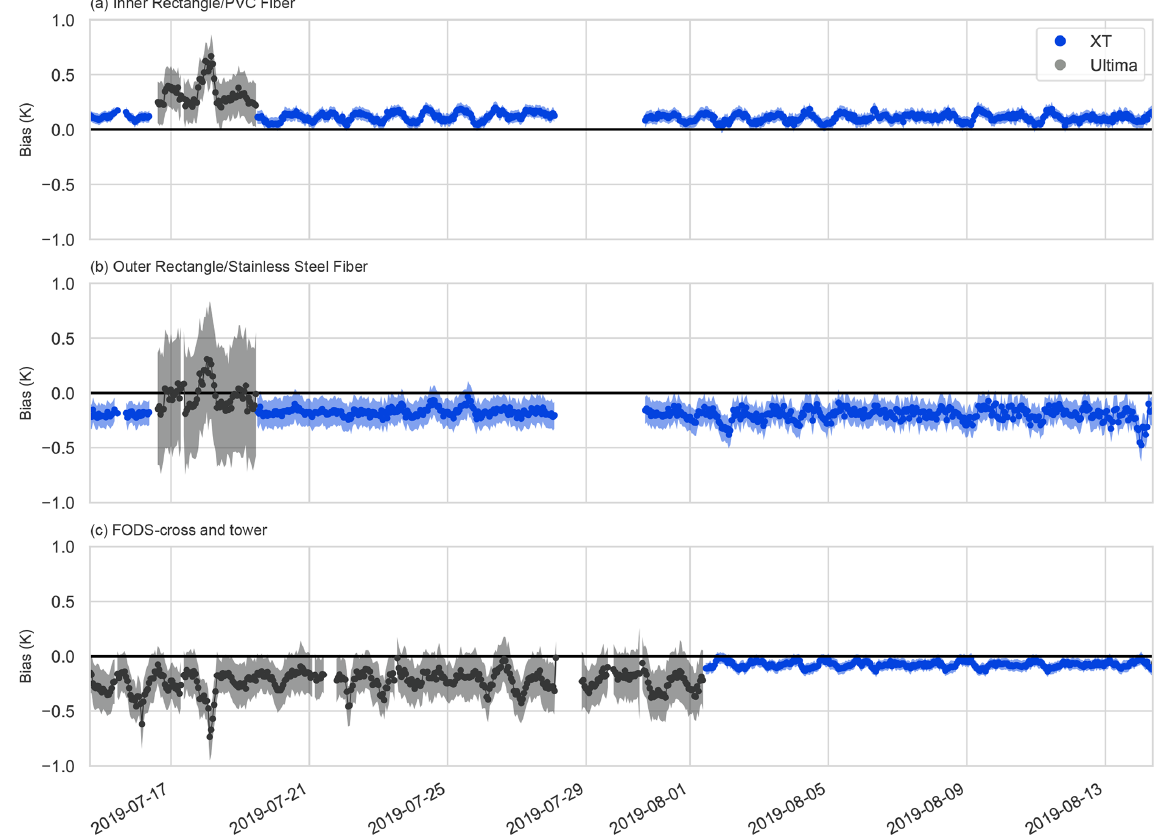
Figure 5. The bias in calibrated DTS temperatures relative to the reference PT-100 in the validation reference section. Biases are averaged over all spatial samples in the reference section and aggregated from the instrument time step to 1h. Solid lines are the mean bias, and the shaded regions are the standard deviation of the bias within the hour. Bias time series are shown for (a) the inner rectangle, (b) the outer rectangle (both described in Sect. 4.1), and (c) the FODS cross (described in Sect. 4.2). The black and blue colors are provided as guidance for selecting lower- and higher-quality data, respectively. The date is given in the format